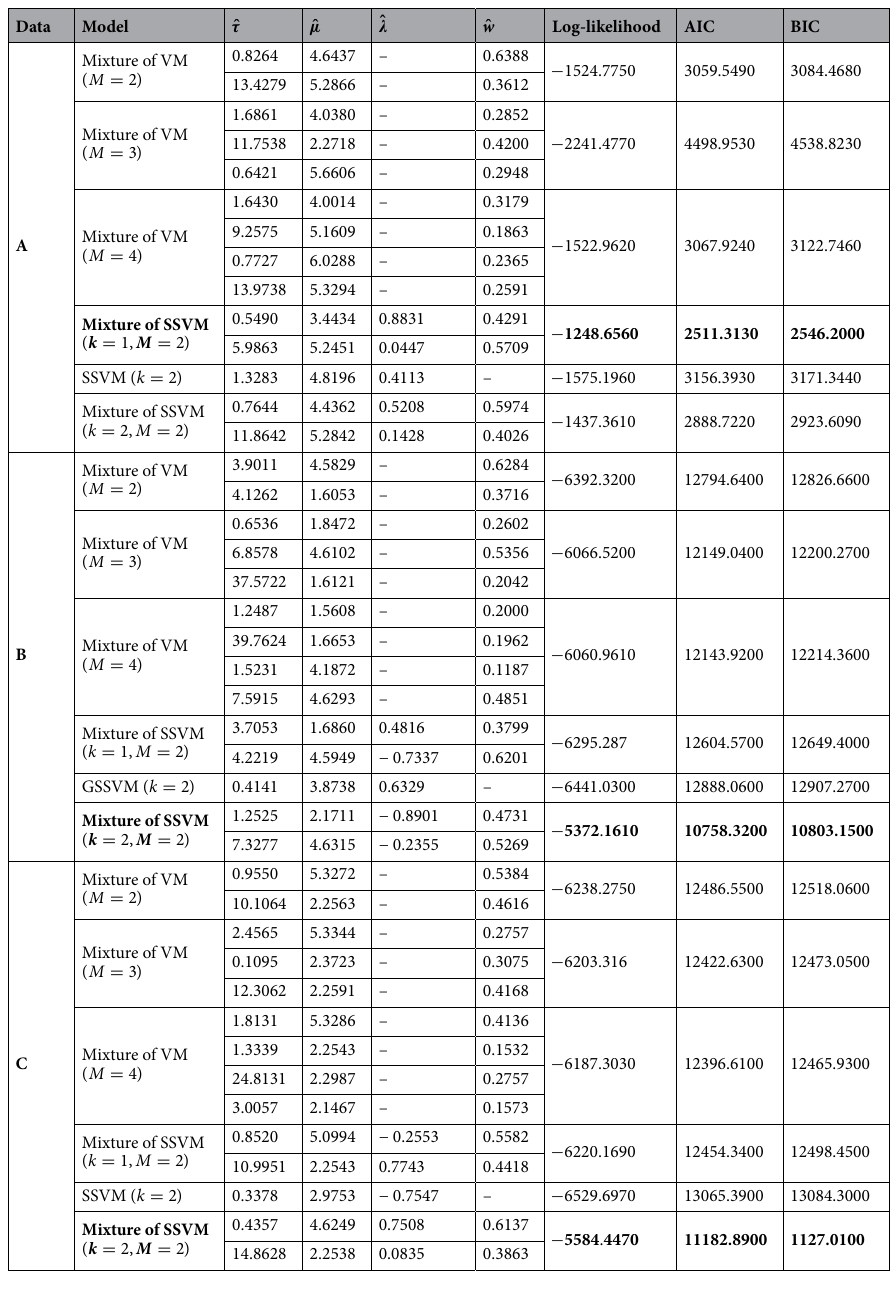
Table 4. Maximum likelihood estimates and corresponding log-likelihood, AIC and BIC for datasets. The best model is indicated in